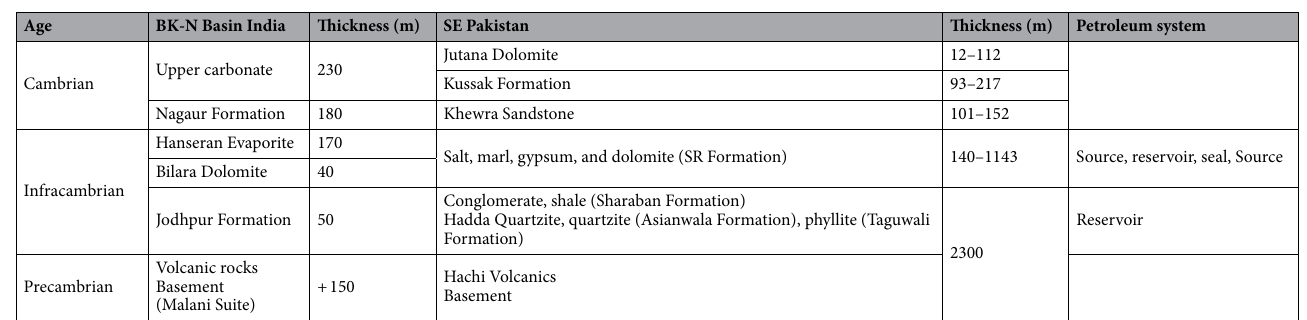
Table 1. Maximum thickness and petroleum system of the Cambrian-Infracambrian succession in SE Pakistan and the Bikaner-Nagaur Basin 10